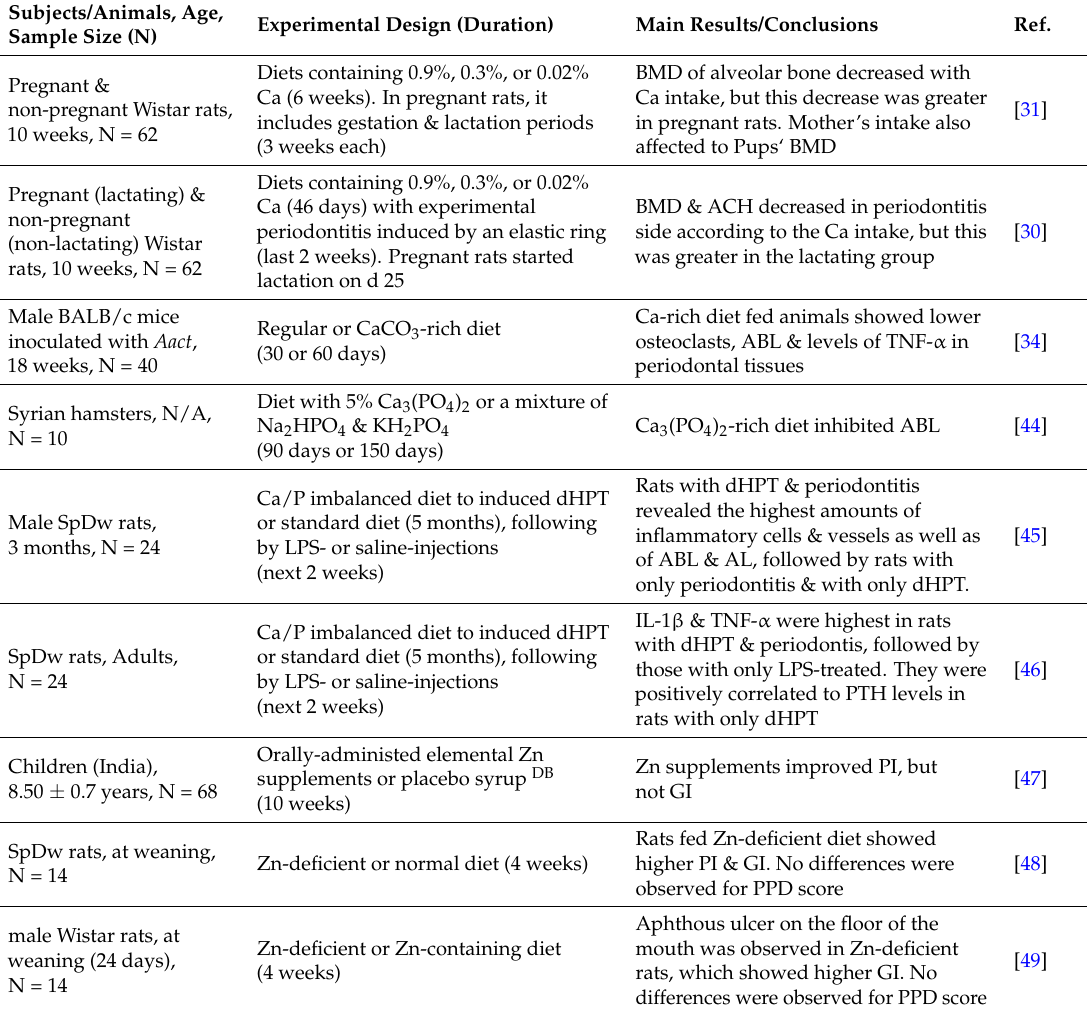
Table 2. Experimental studies on minerals effects on periodontal